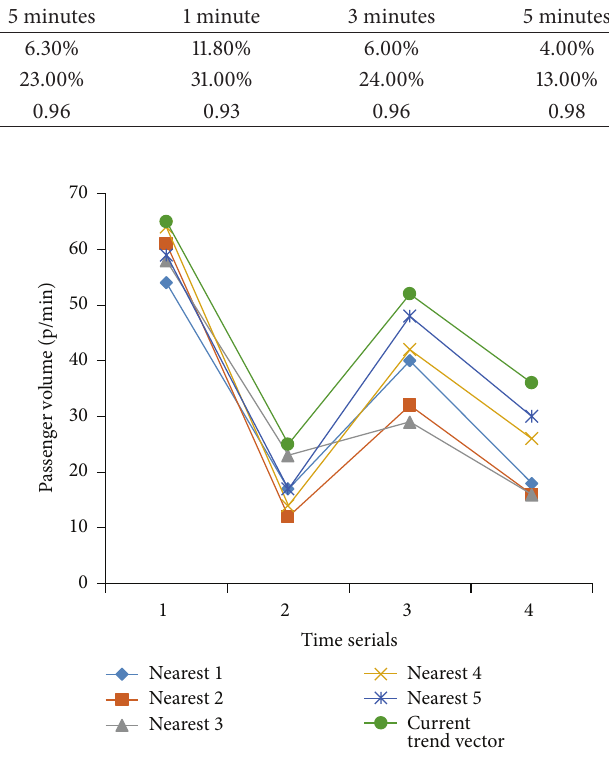
Figure 3: Comparison of state vector of prediction and similar